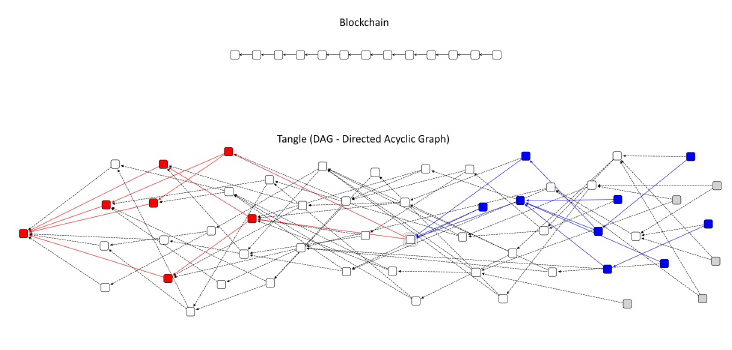
Figure 3. Classical Blockchain structure vs.